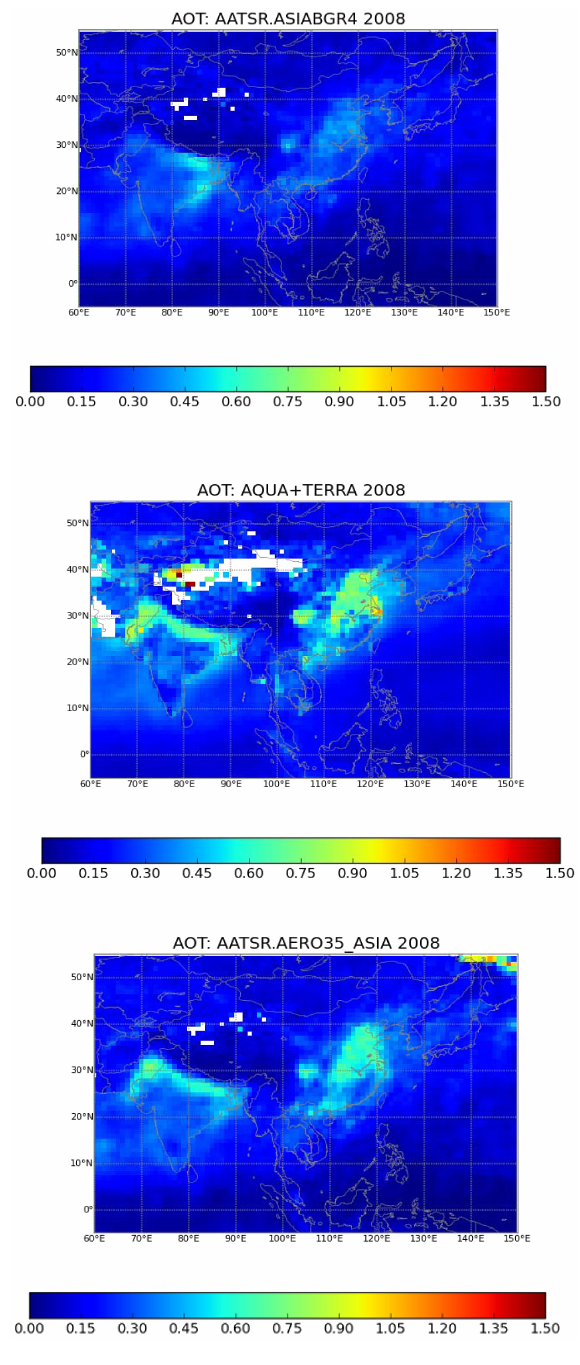
Figure 9. SILAM a priori (top), MODIS observations (middle) and SILAM a posteriori (bottom) AOD, mean over 2008, model output fully collocated with MODIS.